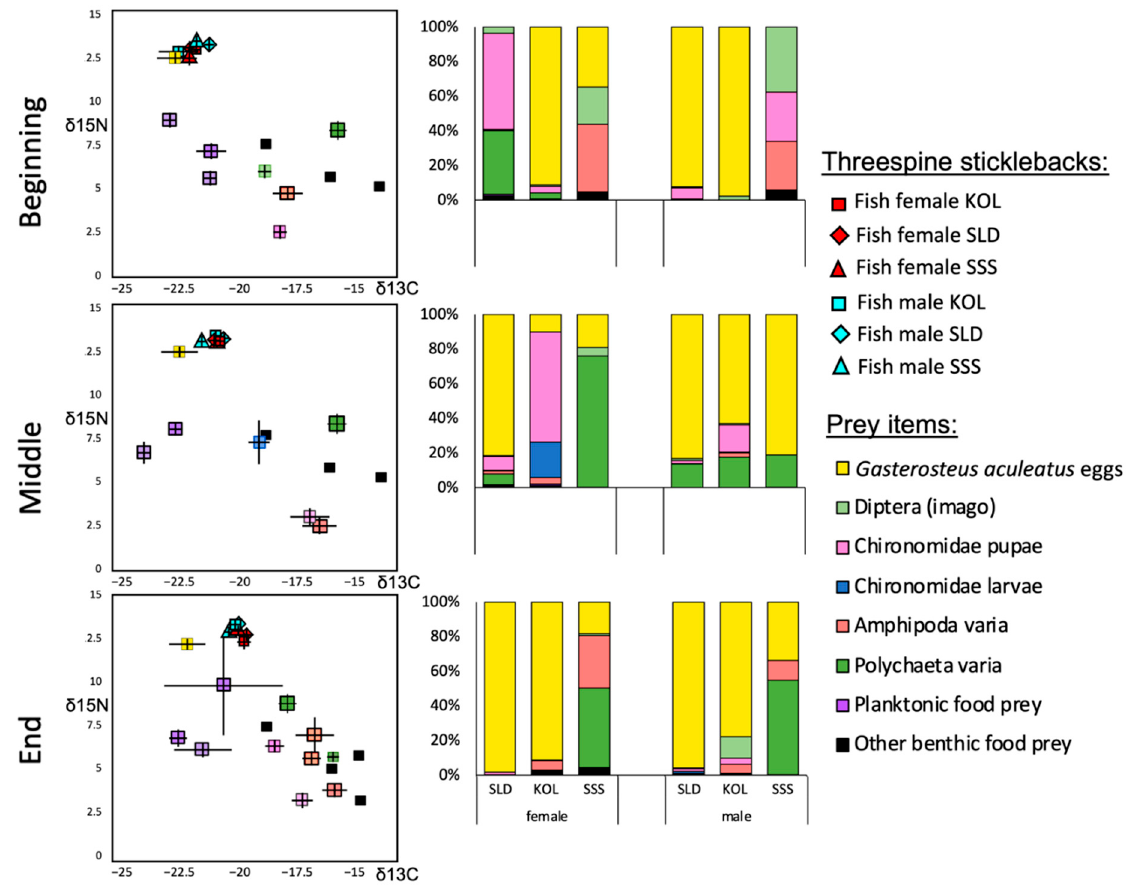
Figure 5. Mean ( ± SE) stable isotope values of carbon δ 13 C and nitrogen δ 15 N content (left column) and stomach contents (right column) of stickleback and their prey items during the spawning period (beginning, middle, and end) at Seldianaya Inlet (SLD), Koliushkovaya Lagoon (KOL), Sukhaya Salma Strait (SSS) in 2016.